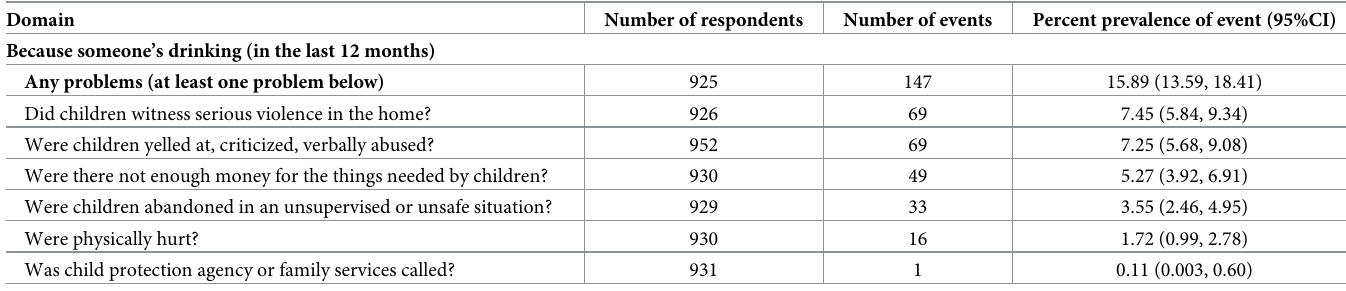
Table 1. The number of identified alcohol-related harms to children.